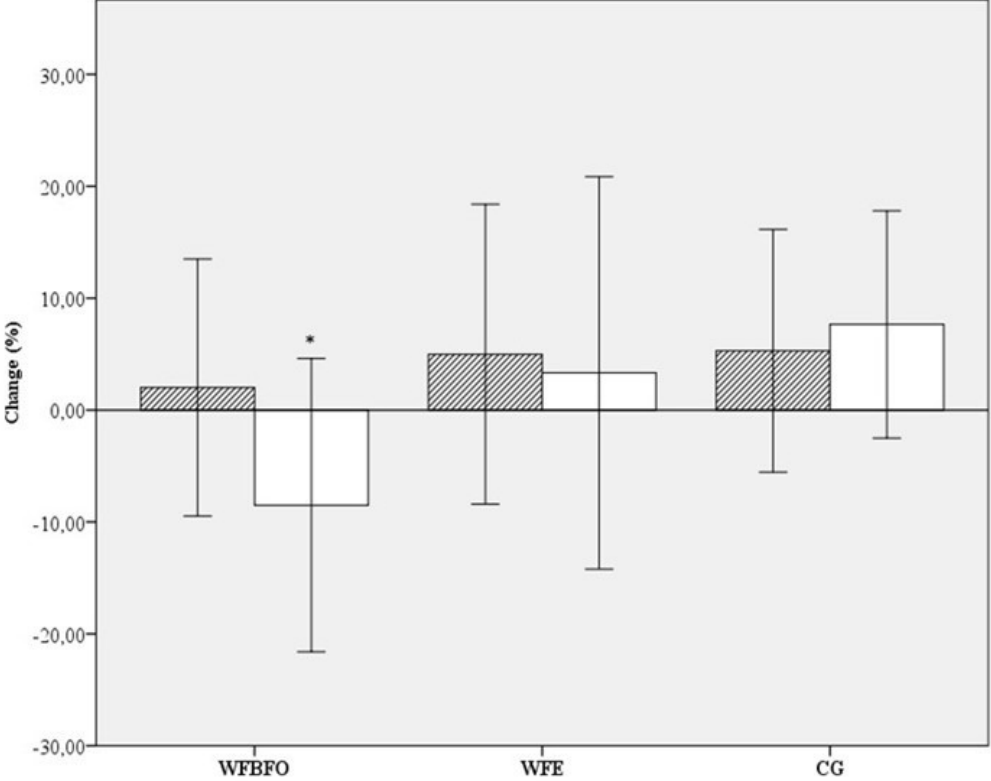
Figure 3. Percentage changes from pre to post-test for variables: heart rate (HR, hatched bars) and double product (DP, open bars), expressed as percentage changes from pre- to post-test. Values are means ± SE. *Statistically significant difference from WFBFR to WFE and CG ( p <